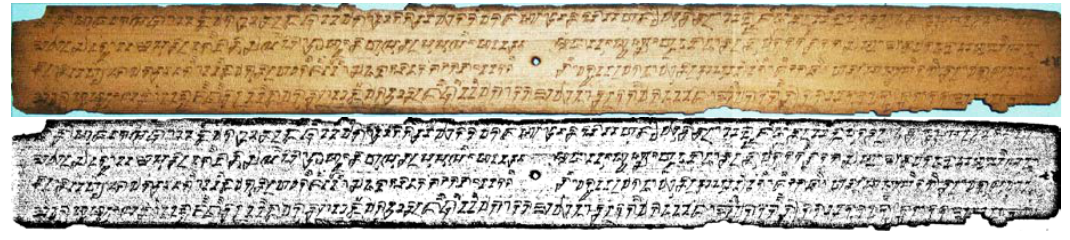
Figure 20. Binarization of Sundanese manuscript with Niblack’s method.